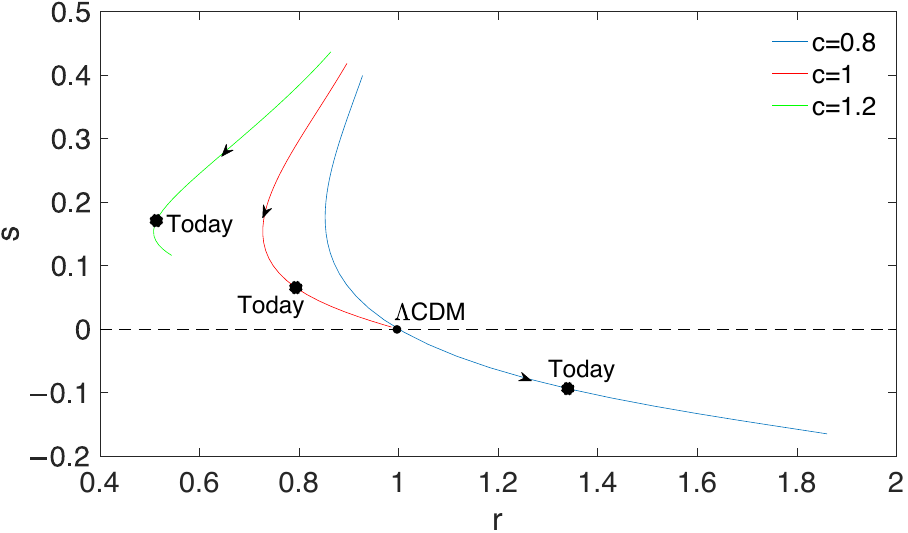
Figure 6. Evolving trajectories of the statefinder in the r − s plane. The arrows denote the evolution directions of s ( r ) . The stars on the curves indicate current states of the model, and the dot symbol is related to the location of the standard Λ CDM model in the r − s